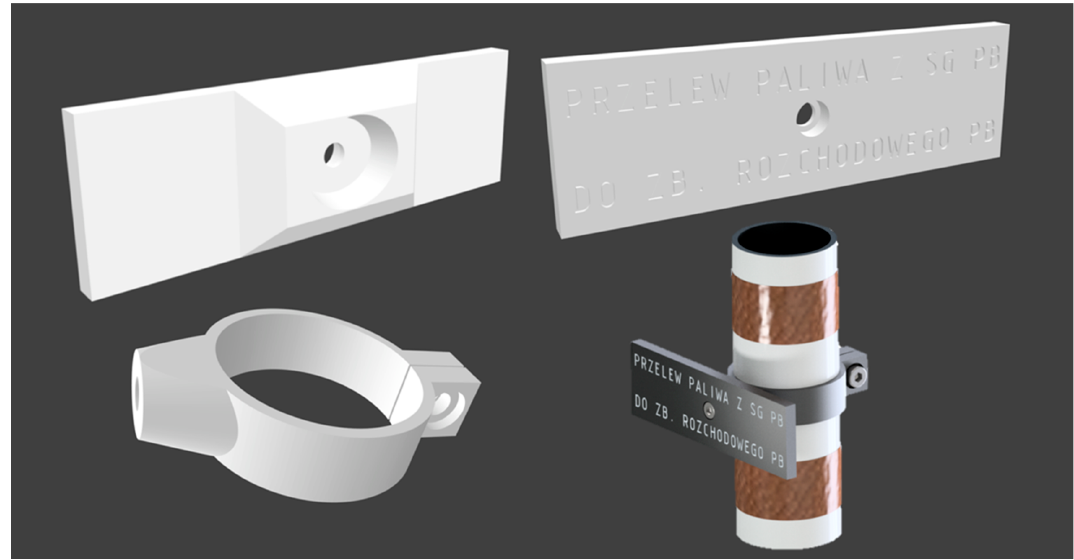
Figure 16. Models of the designed name plate and the mounting. From the top: name plates, view from the back and front, the mounting and the assembly of all components.